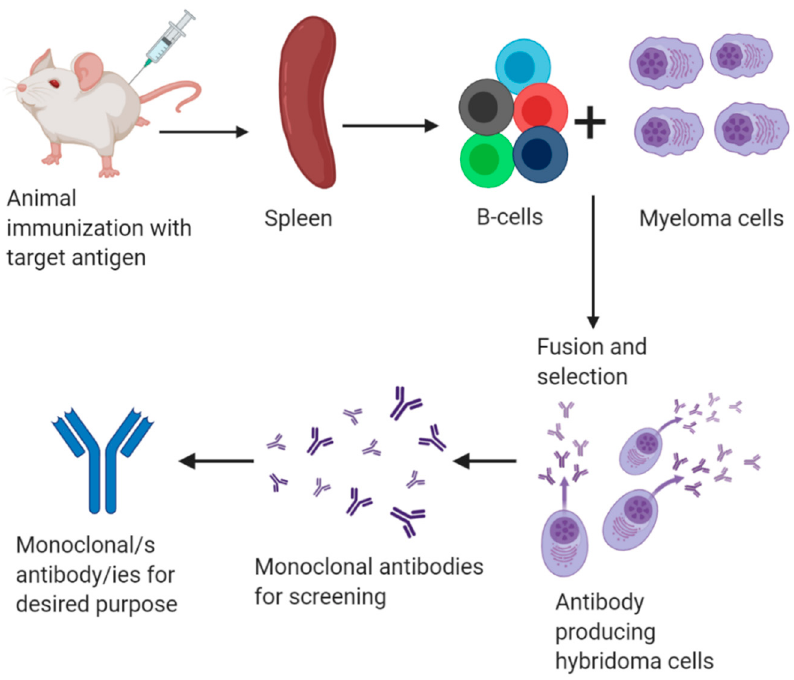
Figure 3. Schematic representation of common monoclonal antibody production.